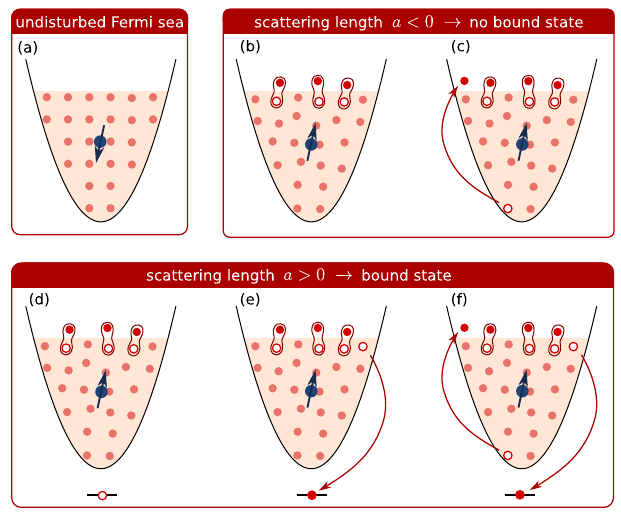
FIG. 3. Schematic illustration of the intermediate excited sets of states giving power-law contributions to the overlap function, which result in the threshold singularities in the RF-absorption spectrum. (a) Undisturbed Fermi sea (impurity is in the j#i state). (b)–(c) Case a < 0 (no bound state): (b) Multiple low-energy particle-hole pairs, giving rise to the leading power-law decay, Eq. (12), of the overlap; (c) an additional particle is promoted from the bottom of the band to the vicinity of the Fermi surface. This contribution leads to the oscillations with period 2 (cid:2) @ =E F in the overlap function [see Fig. 4(a)], as well as to the new cusplike singularity in the absorption spectra [Fig. 2(a)]. (d)–(f) For the case a > 0 , when the impurity potential creates a bound state, there are three important sets of states: (d) The bound state is empty and multiple low-energy excitations are created, (e) the bound state is filled, and (f) an additional particle is excited from the bottom of the band to the Fermi surface. The processes, (d) and (e), lead to the behavior, Eq. (15), of the overlap function while (f) leads to a faster-decaying oscillating contribution. The three contributions result in the absorption spectra shown in Fig.